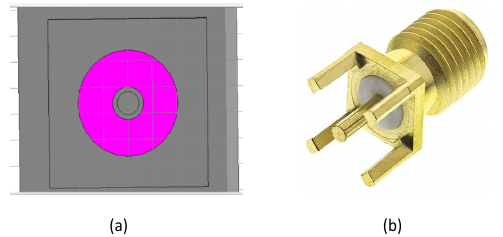
Fig. 3 : 50 Ω coaxial connector used, (a) in simulation (b) in fabrication.